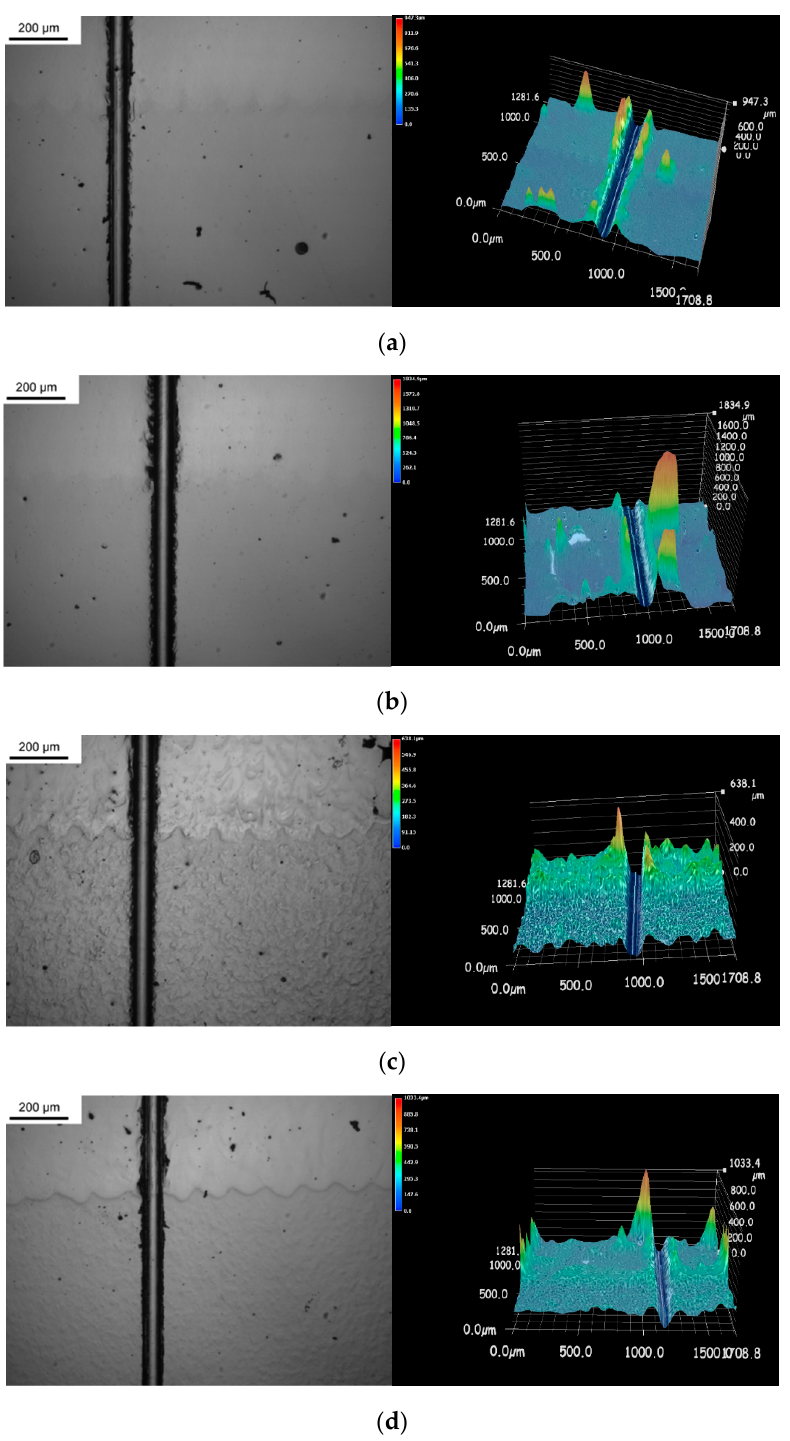
Figure 9. 2D top view and 3D view of the scratch across the cross-section of printed metals and substrate: ( a ) Ra 0.4 µm, ( b ) Ra 0.8 µm, ( c ) Ra 1.4 µm and ( d ) Ra 2.5 µm.